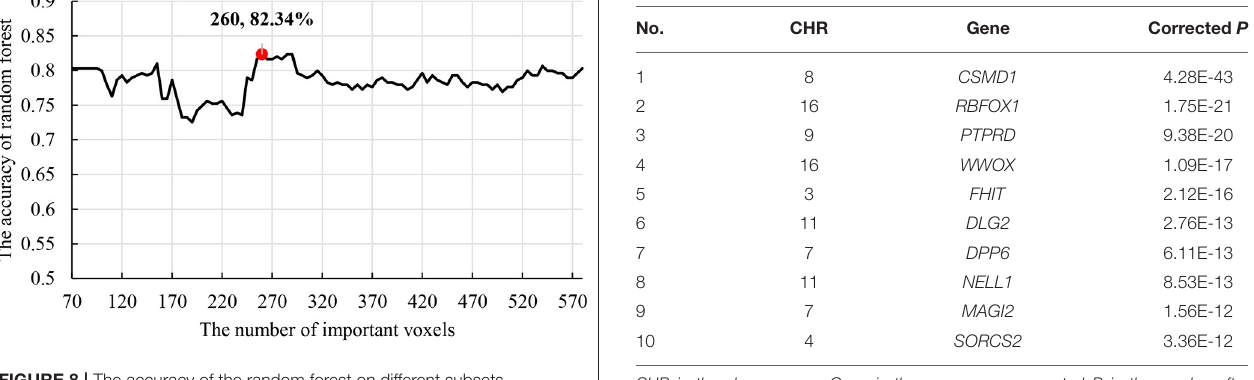
TABLE 4 | The top 10 significant genes identified in our